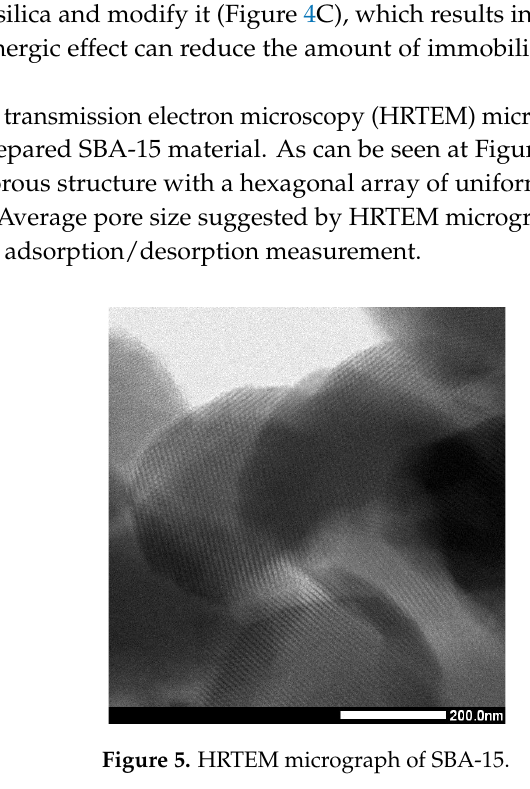
Figure 5. HRTEM micrograph of SBA-15.